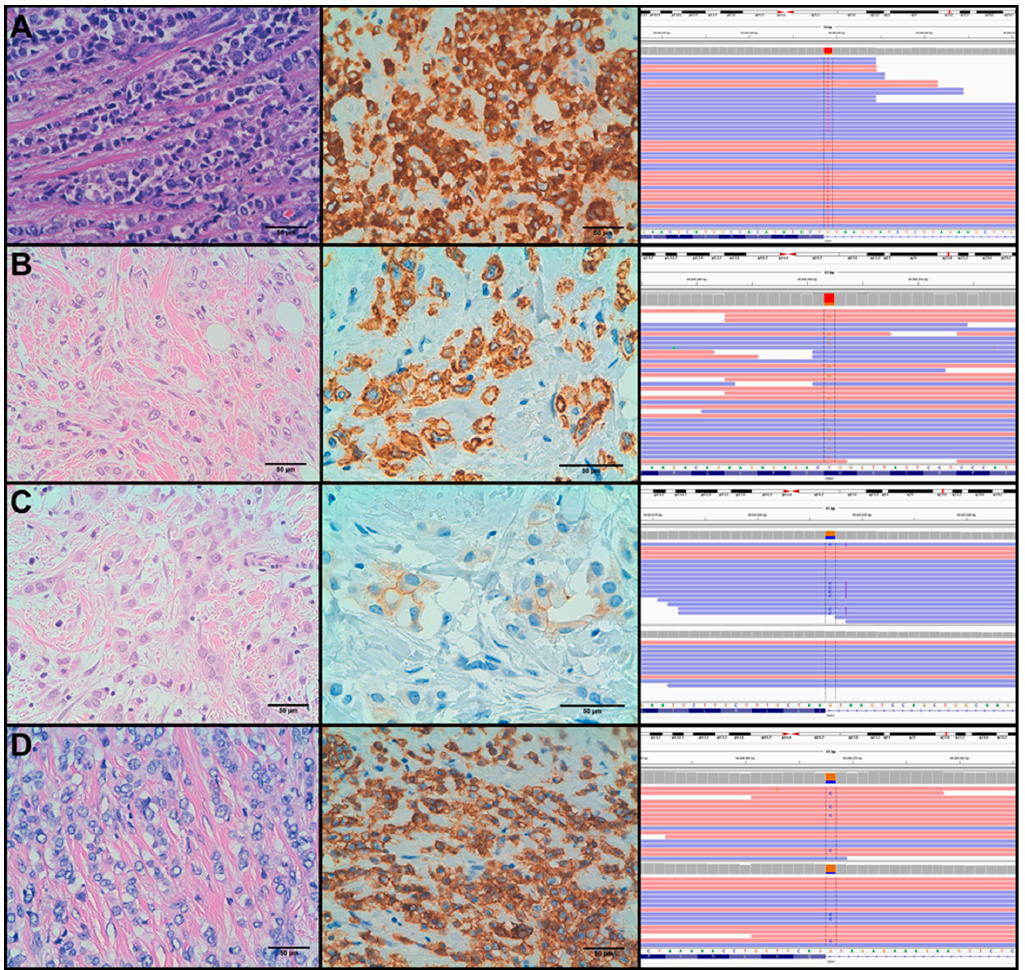
Figure 2. PLC cases showing aberrant expression of E-cadherin: PLC-5 ( A ), PLC-7 ( B ), PLC-18 ( C ) and PLC-22 ( D ). From left to right: H&E, E-cadherin staining and IGV view of CDH1 mutations. In PLC-18 and PLC-22, reads and bases are shown for invasive (top) and in-situ (bottom) components. Regarding other markers, no cases showed p53 overexpression or a null pattern of